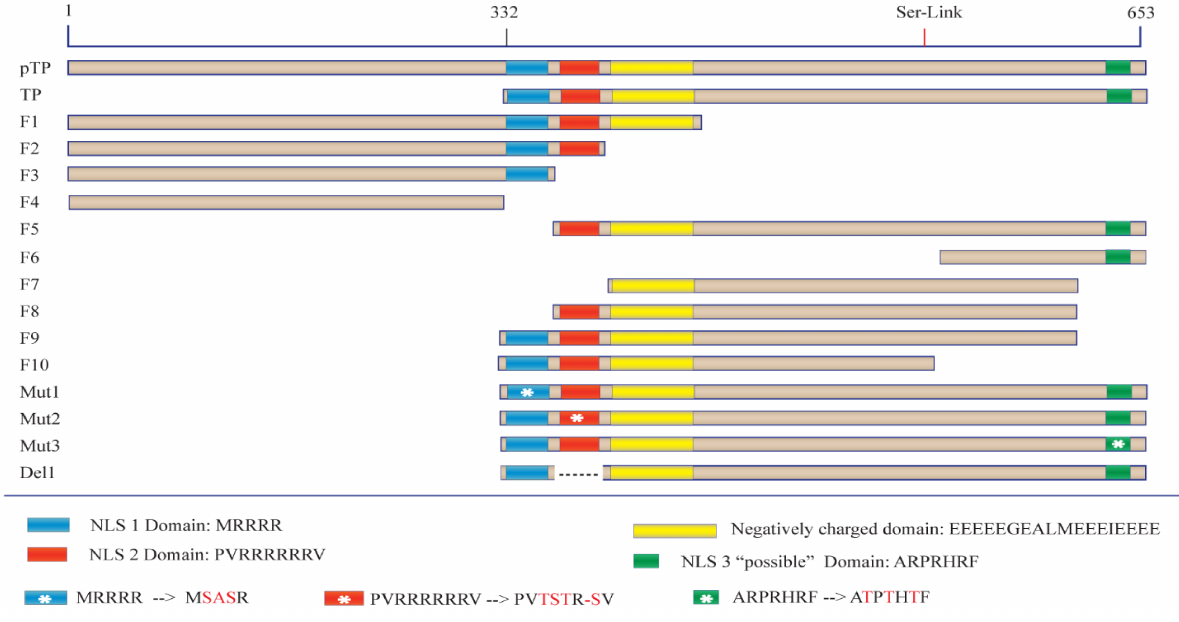
Figure 1. Fragmentation and mutation of preterminal protein (pTP) and terminal protein (TP). Fusion proteins were produced between the C–terminus of GFP and the N–terminus of TP fragments. The constructed fragments are shown with sublegends describing critical domains of interest and mutations are labelled with an asterisk. Ser-link represents the approximate position of the amino acid where TP binds to the viral genome. The starting amino acids of the open reading frame (ORF) is presented as 1 in the figure (see Section 4.1 in Materials and Methods). Mutation details are presented in the legend, and the dashed line signifies a deletion of wild-type amino